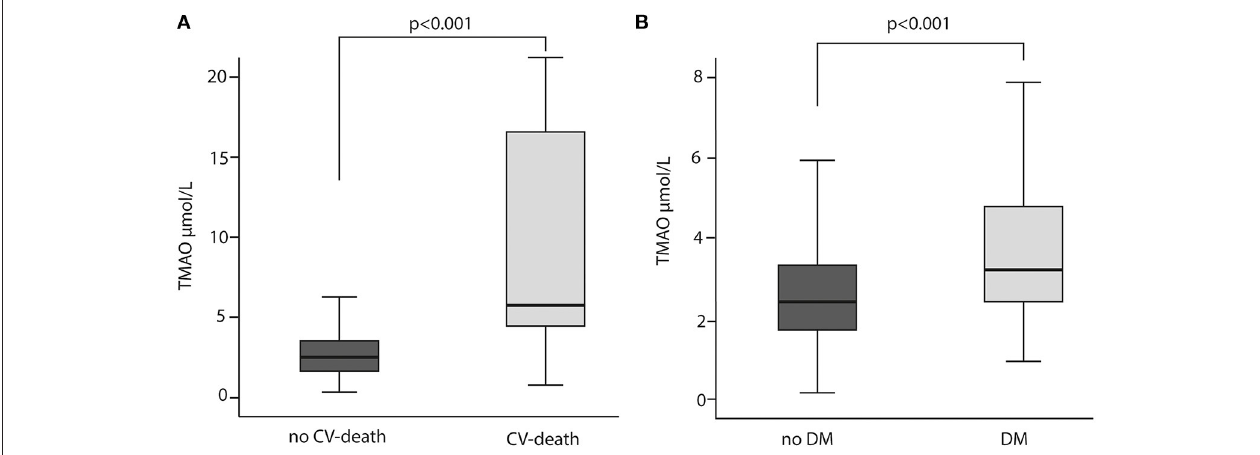
TABLE 2 | Statistical estimates for prediction of cardiovascular death by metabolites.